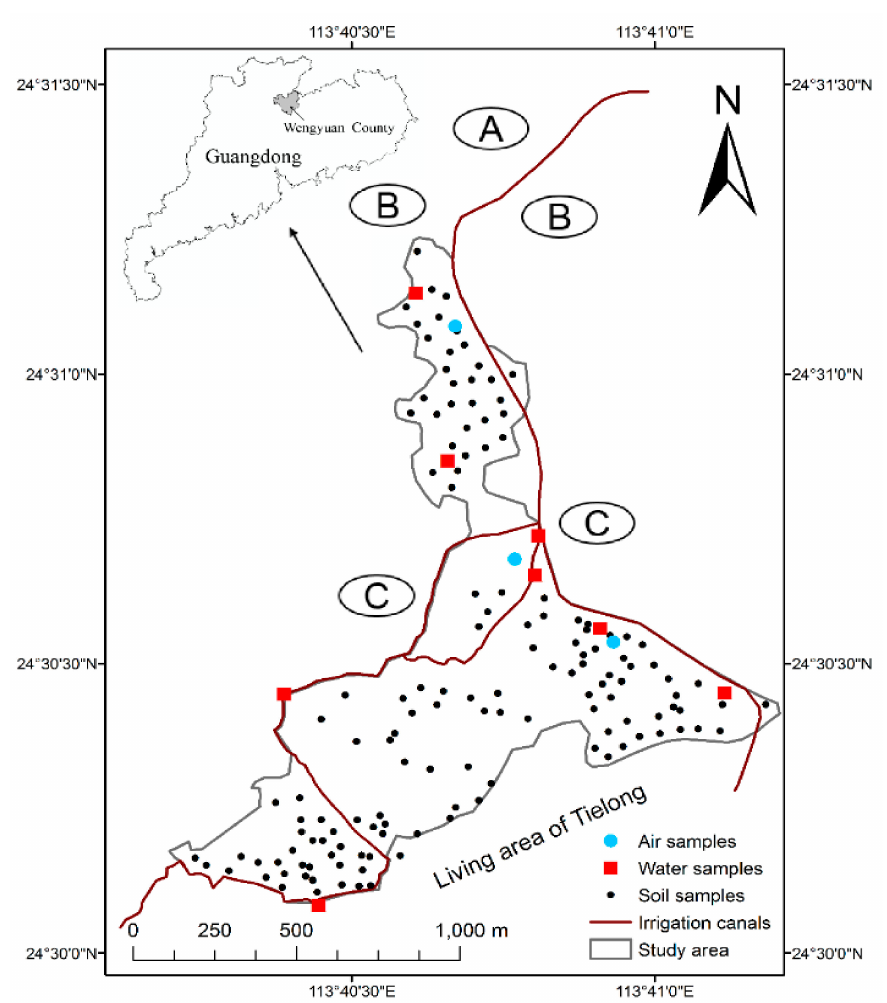
Figure 1. Location of study area and sampling